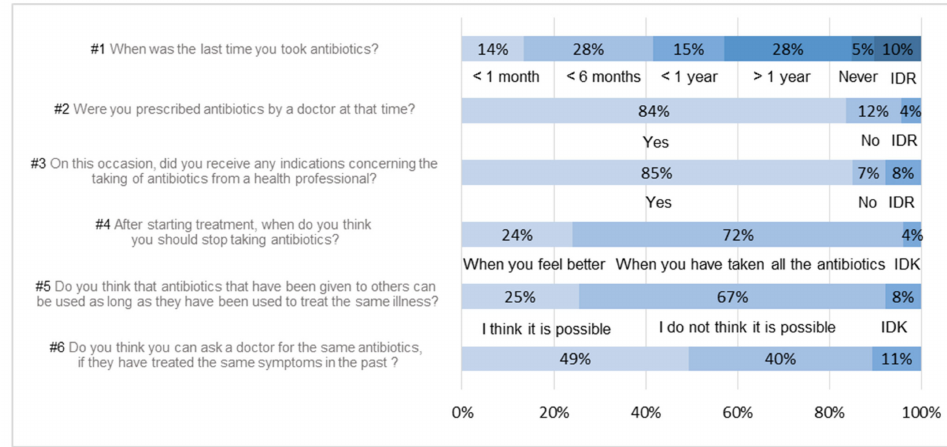
Figure 1. Percentages of response to first 6 questions.